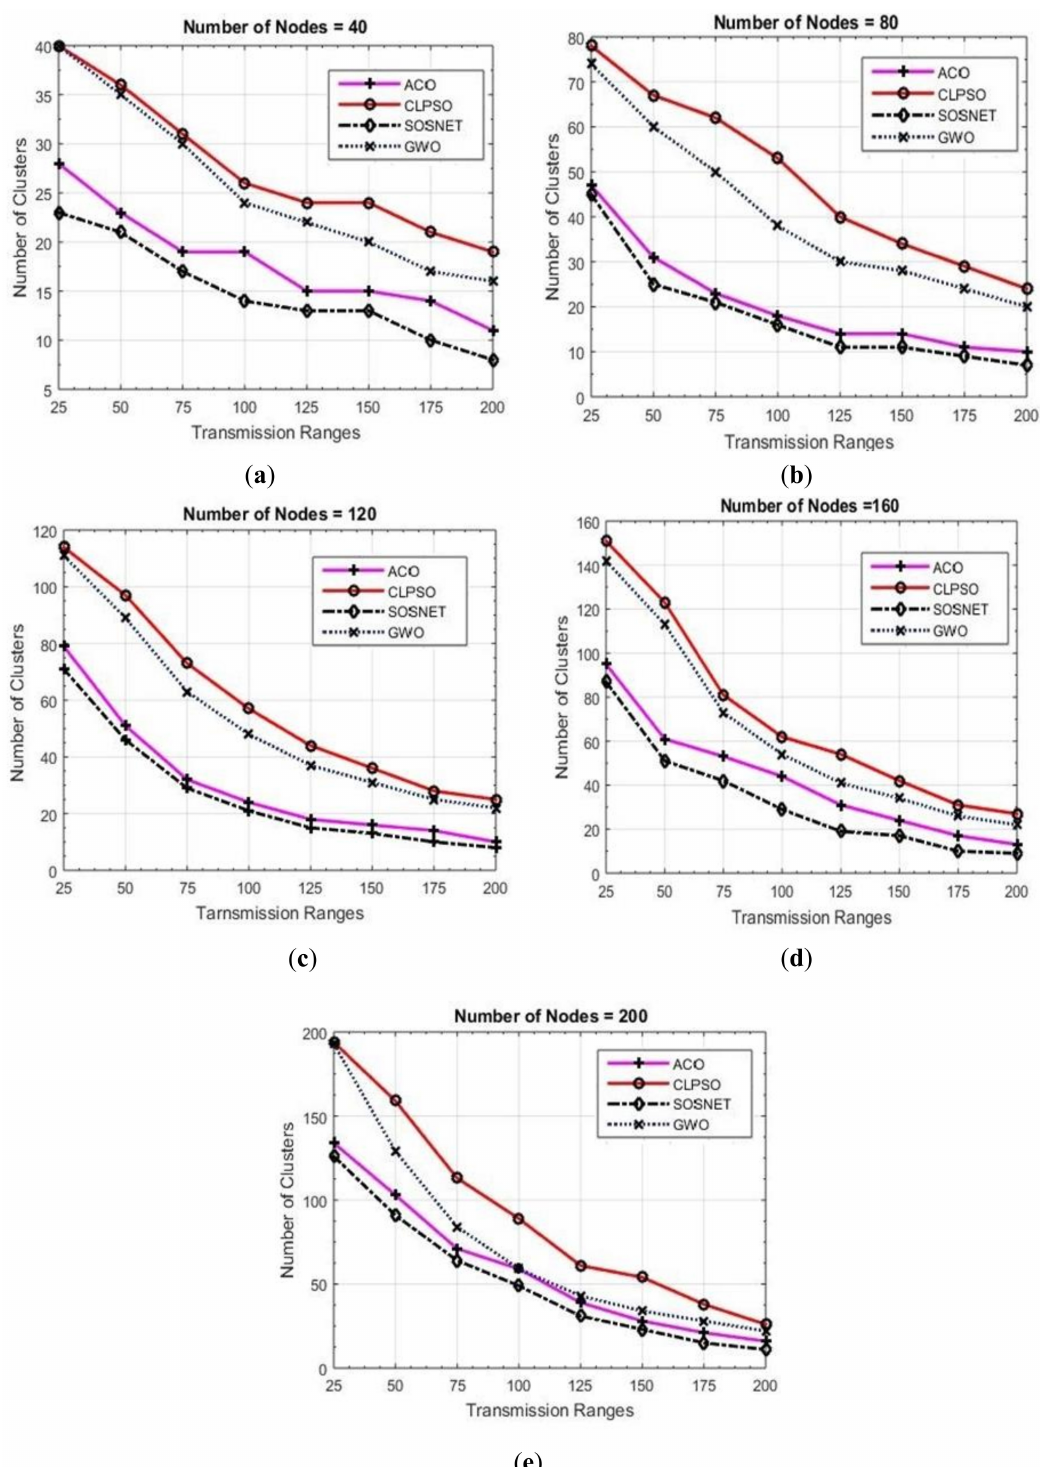
Figure 9. Grid size 2000 m × 2000 m, nodes 40 to